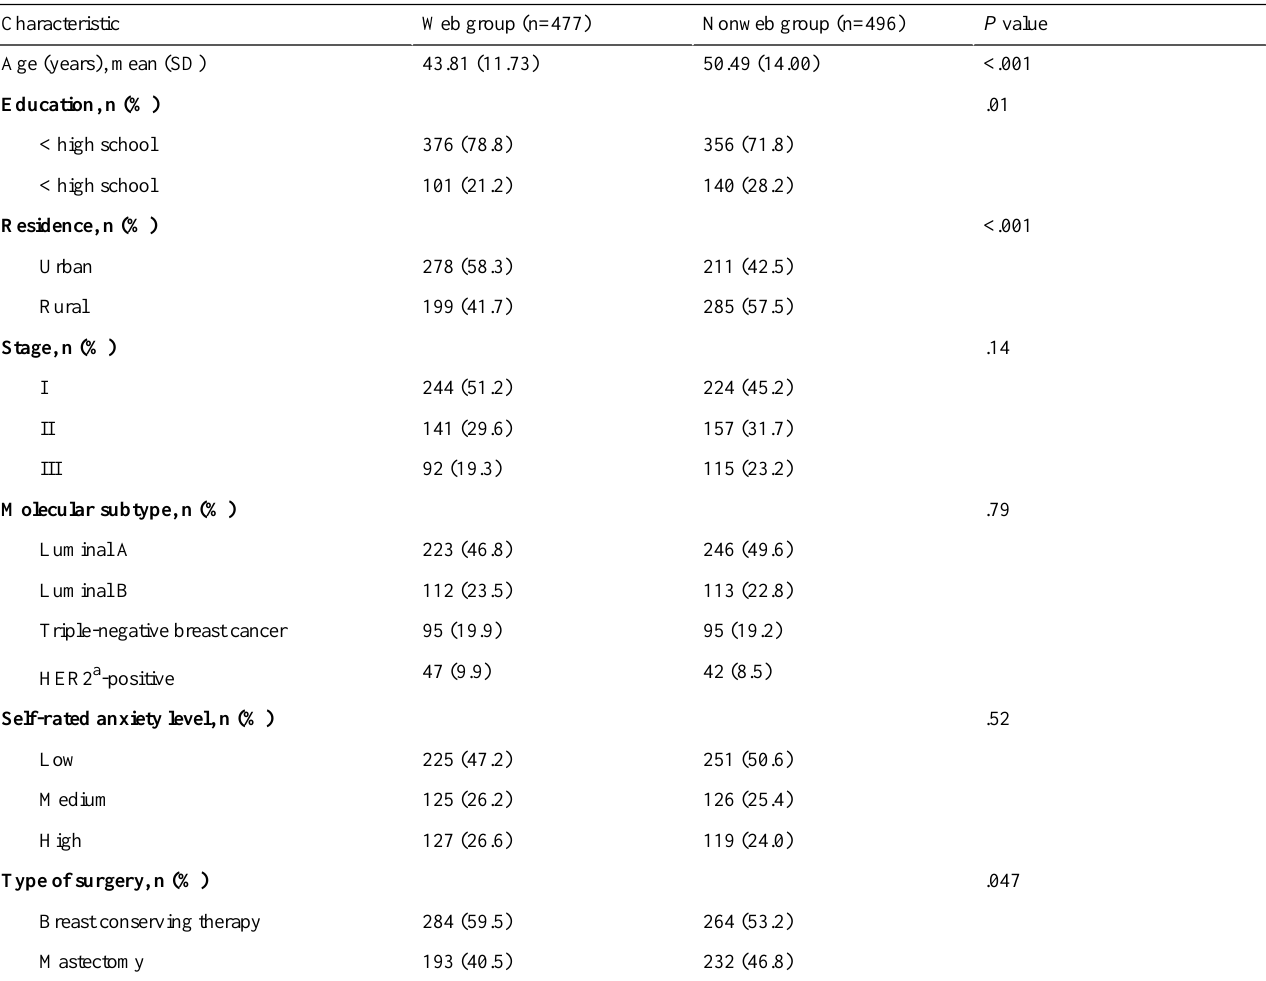
Table 1. Patient characteristics within